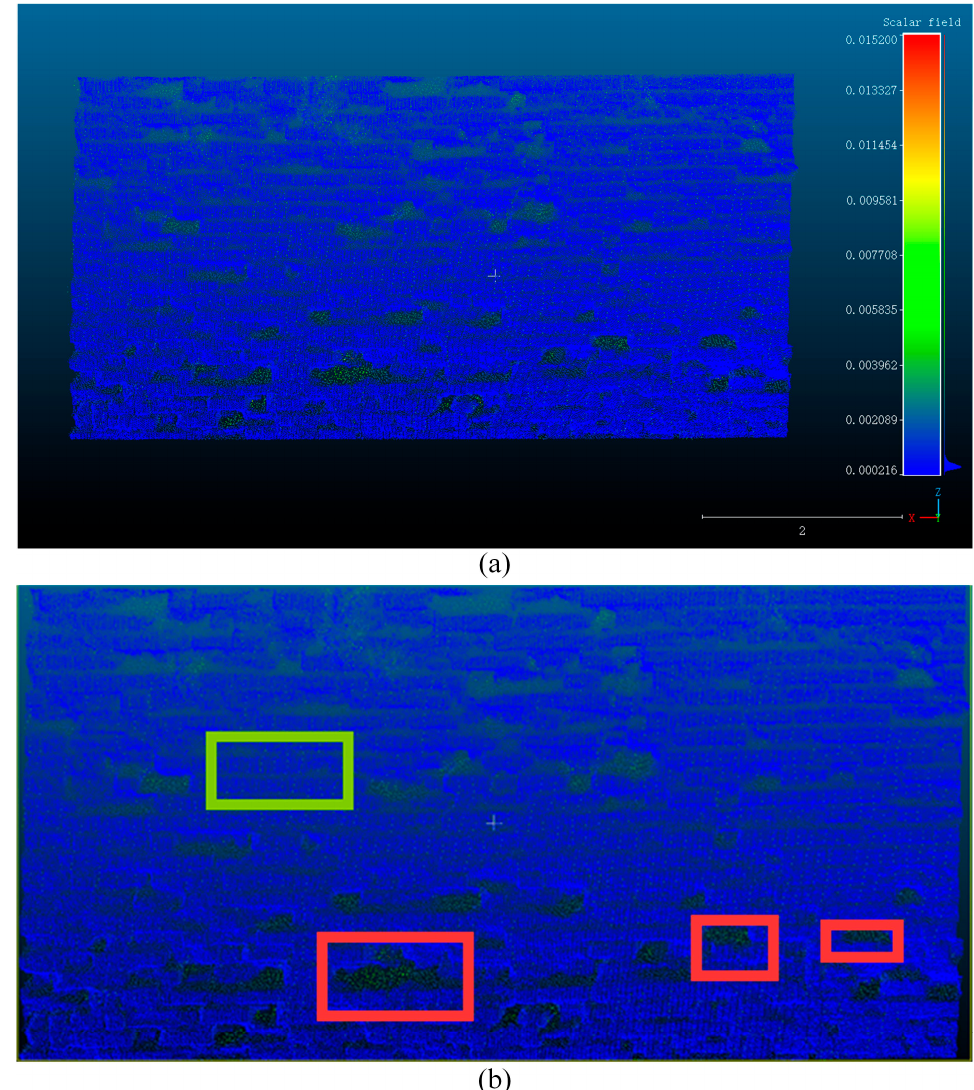
Figure 26. ( a ) Visualization of Structural Tensor “Eigenentropy”. ( b ) Defect analysis diagram. (The red boxes indicate bricks that have fallen o ff , and the green box indicates normal bricks that have not fallen o ff ).